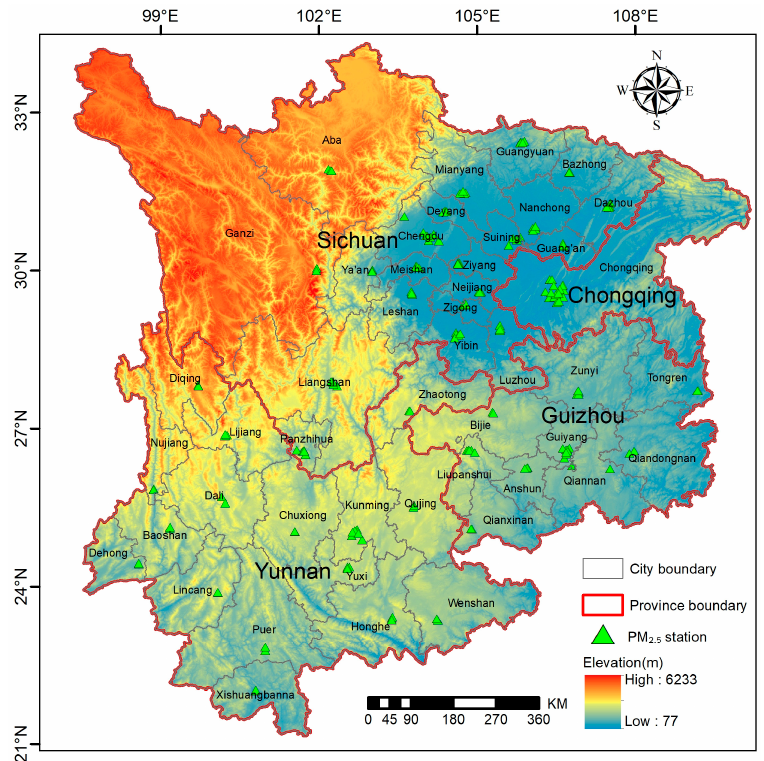
Figure 1. Geographic location and air pollution monitoring stations in southwest China.